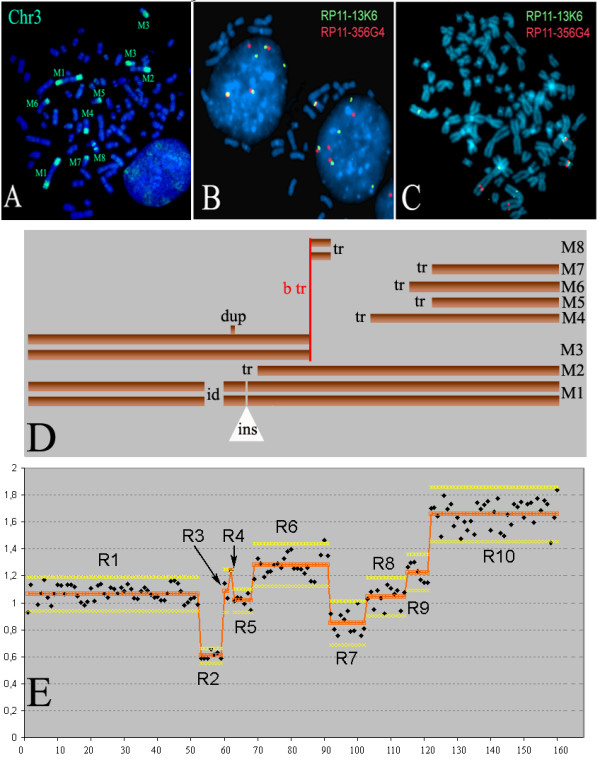
Chr3 rearrangements in UOK147 cell line based on comparison of array-CGH and mpFISH results. A. Chr3 painting probe identifies different chr3 fragments (green) on the rearranged marker chromosomes (M1, M2,...M8).B and C. Interphase (B) and metaphase (C) mpFISH illustration of a pericentromeric rearrangement. Clones RP11-356G4 (red) at 3p11, and RP11-13K6 (green) at 3q11, frame the centromere of chr3. Note the split signal indicating insertion in M1 and loss of red signal indicating loss of 3p through an imbalanced translocation in M2. D. Schematic results of chr3 rearrangements detected by mpFISH. Bars represent chr3 fragments found within the marker chromosomes (M1, M2,...M8). tr: unbalanced translocation breakpoint; b tr: balanced translocation; dup: duplication; id: interstitial deletion; ins: insertion of other chromosome fragment. E. Array-CGH profile. X-axis: displays 179 chr3 BAC clones ordered from 3pter (left) to 3qter (right). Y-axis: normalized fluorescence ratio (NFR). Each spot represents an average between at least two replicas of each clone on the array (see Methods). According to mpFISH we defined specific chr3 regions (R1, R2,...R10) of certain copy number: R1 ANILFR ± 1 sd; 1.07 ± 0.06 corresponds to 4 copies; R2 ANILFR ± 1 sd; 0.61 ± 0.03 corresponds to 2 copies a.s.o (see Table 1). Orange line represents the ANILFR (Average Normalized Inter-Locus Fluorescence Ratio) value and yellow lines frames the double standard deviation intervals for each region (Methods). (see Table 1). (Note: the measurement points from individual PAC/BAC clones, which reside outside the double standard deviation, must be confirmed by FISH to be able to rely on them. In this case FISH confirmed only one single clone change -R4).